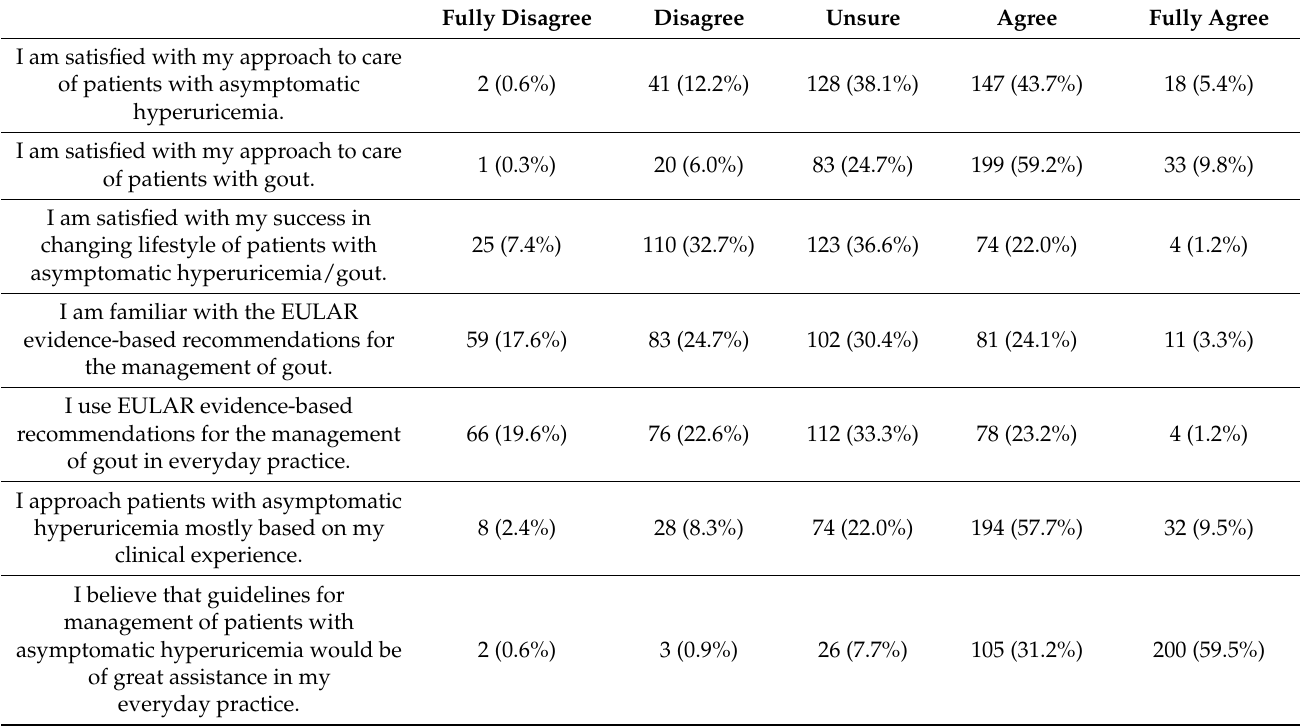
Table 3. Attitudes about gout and asymptomatic hyperuricemia